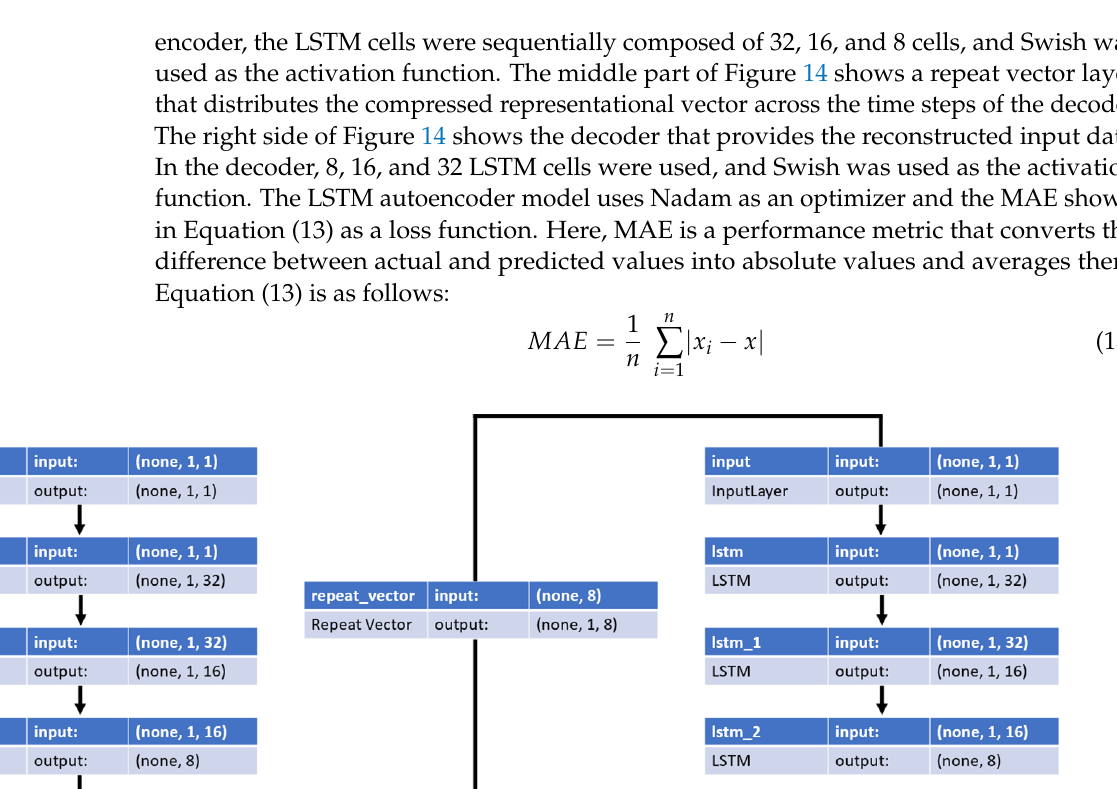
Figure 16. Anomaly detection graph based on the threshold of the LSTM autoencoder in the test set. 3.8. Comparison of Six Anomaly Detection Algorithms In Section 3.8, the six algorithms mentioned above were compared and analyzed. Threshold averaging algorithms detected anomalies based on maximum and minimum thresholds. However, as shown in Figure 5, it could detect anomalies well at the maximum threshold, but not well at the minimum threshold. Therefore, depending on the data ac- quired, the selection of a maximum or minimum threshold may be necessary. Unlike threshold averaging algorithms, the five algorithms mentioned later are models trained by training data.